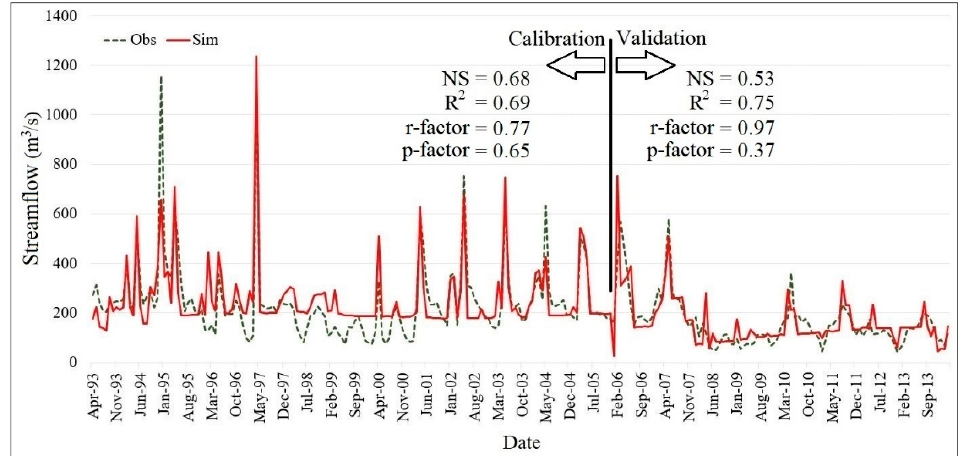
Figure 4. Calibration (1993–2005) and validation (2006–2014) of monthly streamflow in Dezful station.